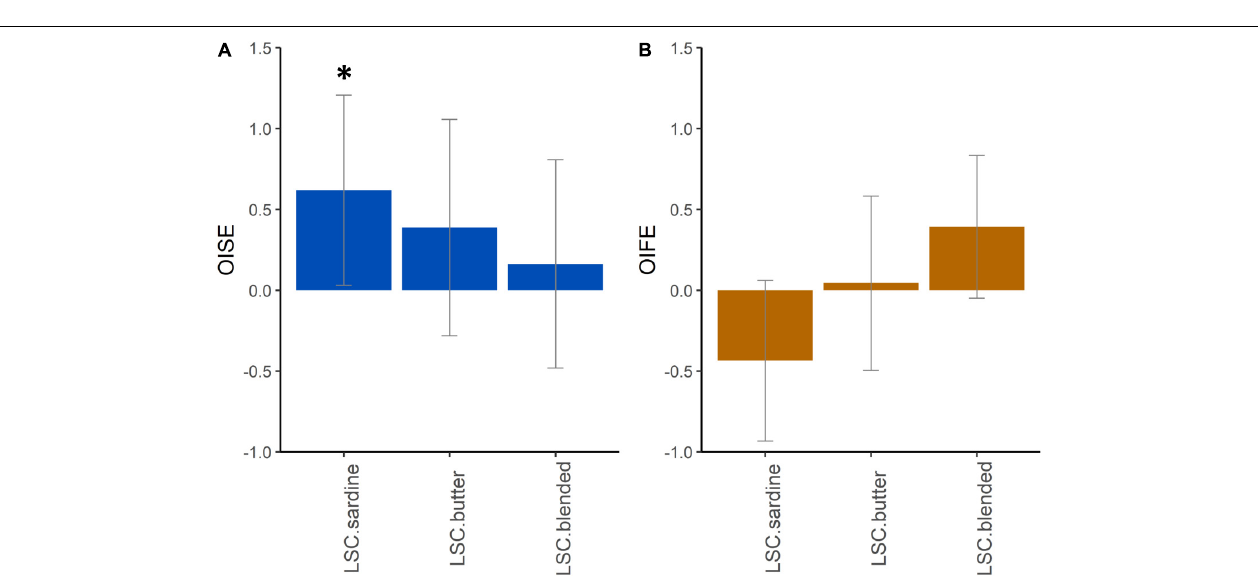
FIGURE 3 | Mean odor-induced saltiness enhancement (OISE; A ) and odor-induced fat perception enhancement (OIFE; B ) for low-salt cheeses flavored with a sardine, butter or blended aroma. Error bars indicate 95% confidence intervals on the mean. The star indicates a statistically significant OISE ( ∗ p < 0.05).